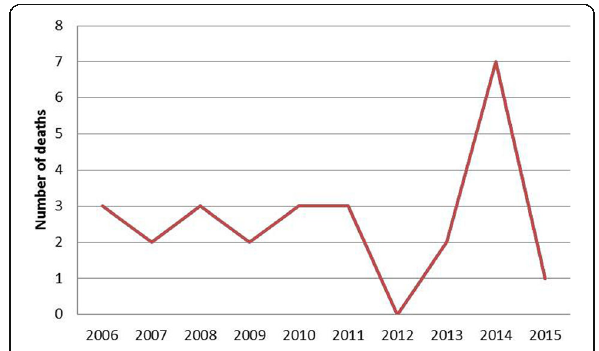
Fig. 1 Distribution of the cases according to year Fig. 2 Distribution of deaths of natural causes